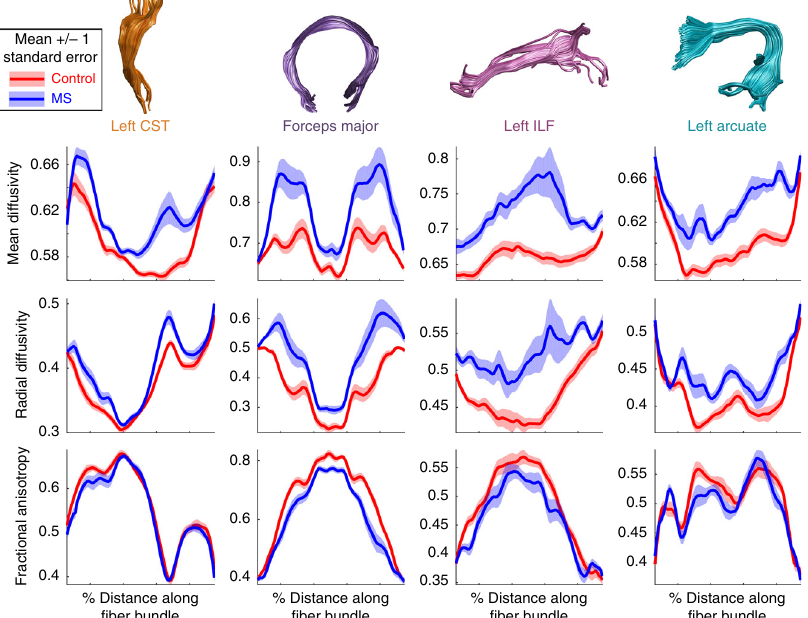
Fig. 2 Group comparison between multiple sclerosis patients and healthy control subjects. We observe highly signi fi cant ( p < 0.001) group differences in diffusion measures across many tracts. Mean diffusivity (top panel) and radial diffusivity (middle panel) show larger group differences than fractional anisotropy (bottom panel). Mean values + /- 1 standard error are shown for control subjects in red and multiple sclerosis (MS) patients in blue (see Figure3_4_MultipleSclerosis.m and